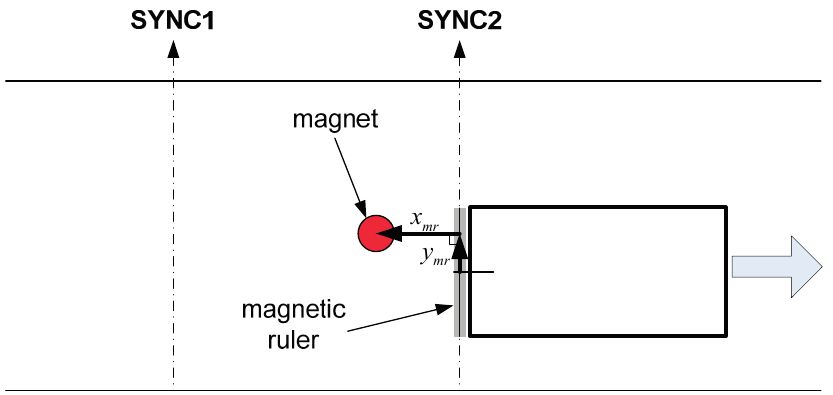
Figure 5. Vehicle local Cartesian coordinate system to determine the relative position of the magnetic markers based on peak detection by the MFS.